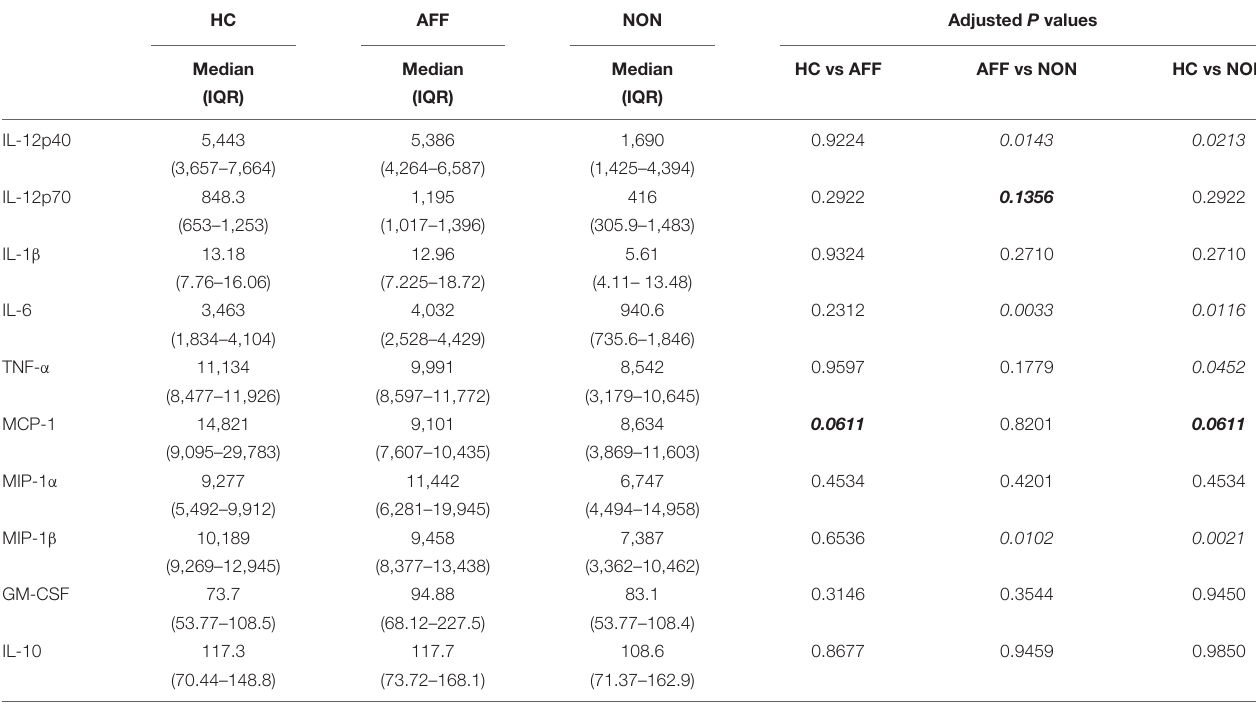
TABLE 4 | Concentration of cytokines/chemokines after LPS plus IFN γ